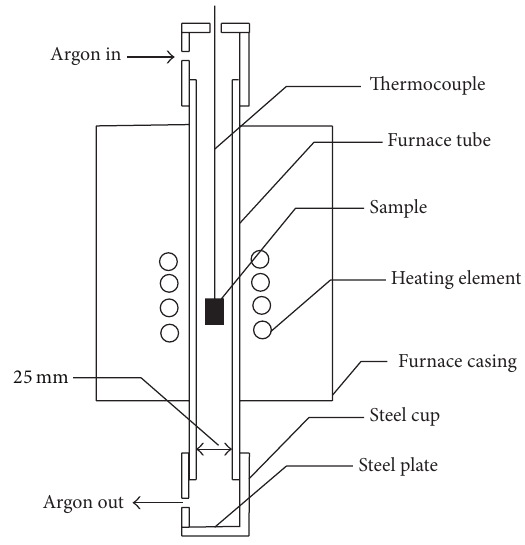
Figure 2: Schematic of the furnace setup for remelting